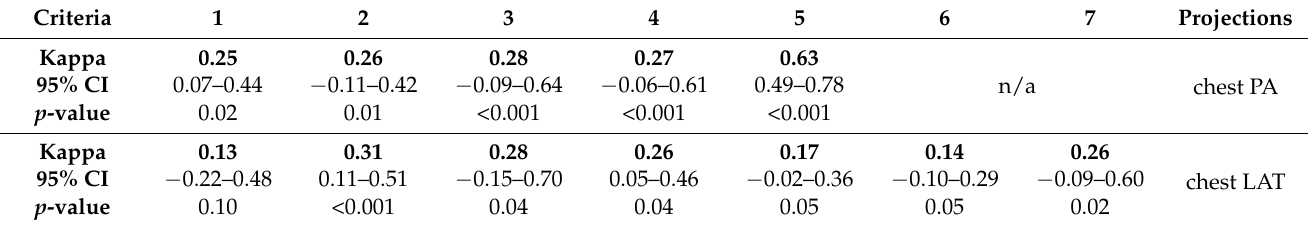
Table 8. Weighted kappa assessing intraobserver agreement for each image quality criterion in the chest PA/LAT protocol. Criteria